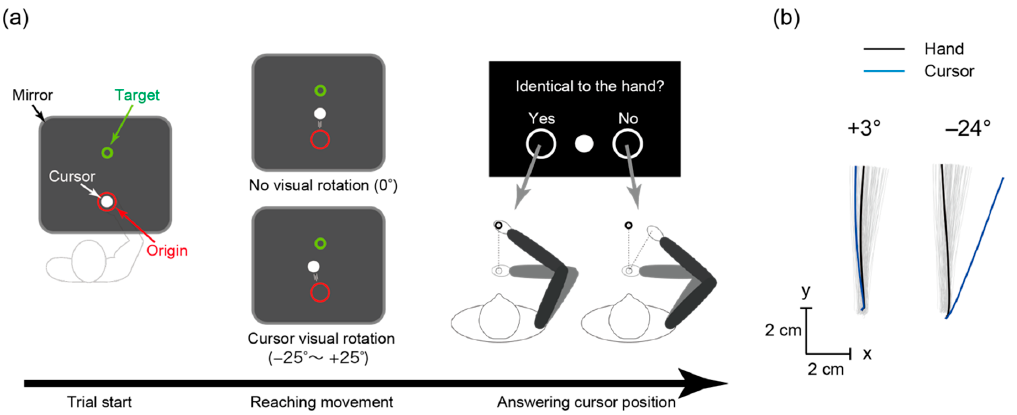
Figure 1. The arm-reaching task. ( a ) Participants moved their hand from the red origin towards the green target. Their hand and arm were not visible, and the white-cursor position could be visually rotated. After each trial, they answered whether the cursor and hand positions coincided by moving the handle towards the left or right. ( b ) Hand trajectories from a representative participant (gray lines), and examples of hand and cursor trajectories for small (+3°) and large ( − 24°) rotation angles.